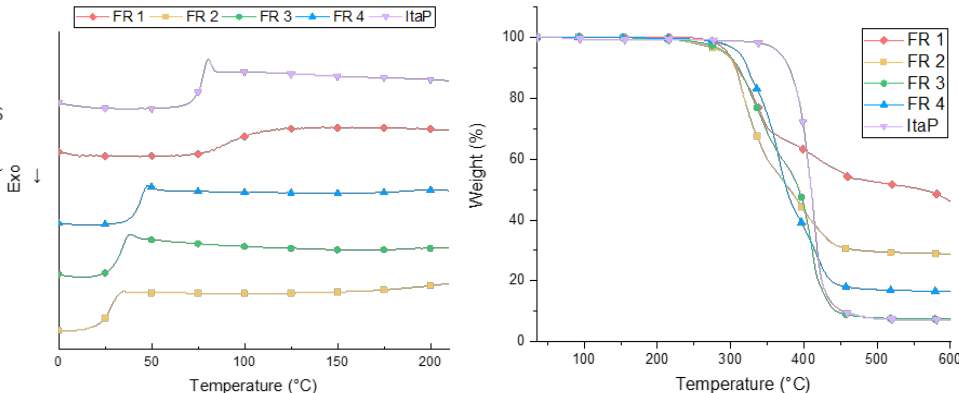
Figure 2. Di ff erential scanning calorimetry (DSC) (left) and thermogravimetric analysis (TGA) (right) curves of FR 1–4 and ItaP with a heating rate of 10 K / min from 0–210 ◦ C (DSC) and 35–600 ◦ C (TGA) in nitrogen atmosphere. Table 1. Tg, T 1% and Residue of FR 1–4 and ItaP obtained by DSC and TGA with a heating rate of 10 K min − 1 in nitrogen atmosphere.